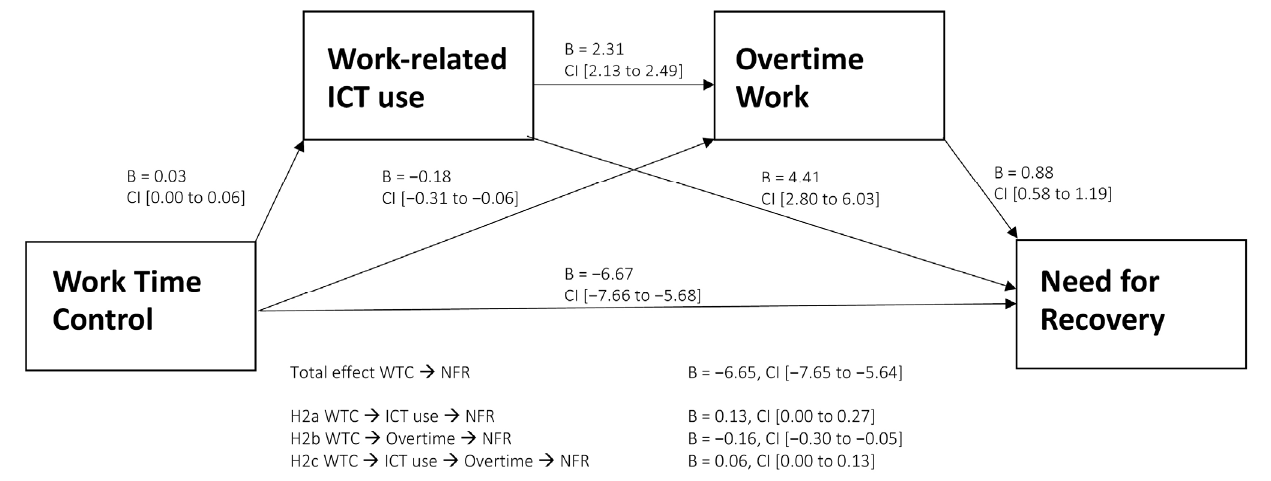
Figure 2. Results of the serial mediation test of the relationship between work time control and need for recovery, through work-related ICT use outside of regular working hours and overtime work in simple and serial indirect effects. The B-values (95% confidence intervals) show the unstandardized coefficients after adjustment for age, gender, and children at home. Values for direct associations between the factors are presented in the figure. The coefficients for the three indirect effects, presented below the figure, align with their respective hypotheses.